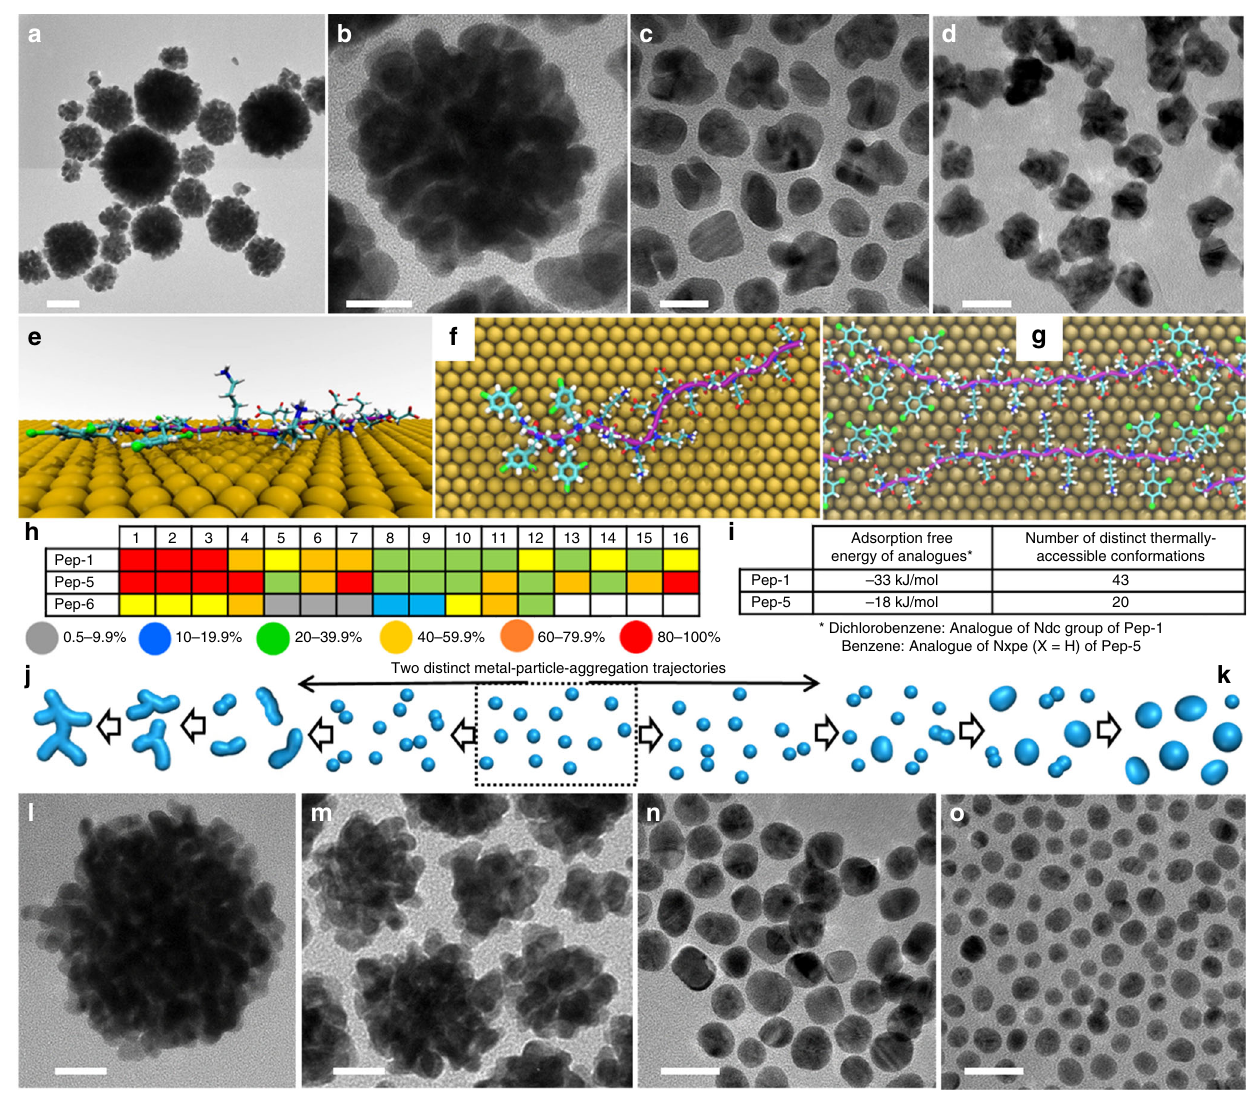
Fig. 3 Predictable morphological evolution of gold nanomaterials induced by peptoids. a – d TEM images (scale bar, 50 nm for a, and 20 nm for b – d ) of gold nanomaterials induced by Pep- 4 ( a , b ), Pep- 5 ( c ), and Pep- 6 ( d ). e – g Representative structures of Pep- 1 adsorbed at the aqueous Au(111) interface predicted from REST-MD simulations in which ( e , f ) are single chain, side and plan views and ( g ) is two-chain plan view indicating favorable inter-peptoid contacts. Color code: C, cyan; O, red; N, blue; Cl, green; the peptoid backbone is colored purple. Water molecules are not shown for clarity. h Average degree of peptoid-surface contact, on a residue-by-residue basis, predicted by REST-MD simulations for each of Pep- 1 , Pep- 5 , and Pep- 6 adsorbed at the aqueous Au(111) interface. The side-chain residue numbers were enumerated from the N- to C-termini. i The adsorption free energy of both dichlorobenzene and benzene, as analogues of Ndc of Pep- 1 and Nxpe (X = H) of Pep- 5 respectively, at the aqueous Au(111) interface; The number of distinct thermally accessible conformations of Pep- 1 and Pep- 5 generated from a clustering analysis of surface-adsorbed Pep- 1 and Pep- 5 (Supplementary Methods and Supplementary Table 1). j , k The schemes showing two distinct, well-known metal-particle-aggregation trajectories, in which the slow aggregation and fast relaxation of metal NPs lead to the fusion and formation of dumbbell structures that then relax back to spherical shapes ( k ) 35,36 ; when aggregation is rapid, but relaxation is slow, dendritic structures typical of diffusion-limited aggregation form ( j ) 37,38 . TEM images of gold nanomaterials (scale bar, 20 nm) induced by Pep- 7 ( l ), Pep- 8 ( m ), Pep- 9 ( n ), and Pep- 1 at pH 5.5 ( o ) in which the predictable evolution from gold spherical coral to spherical particles produced as peptoids move from high to low binding af fi